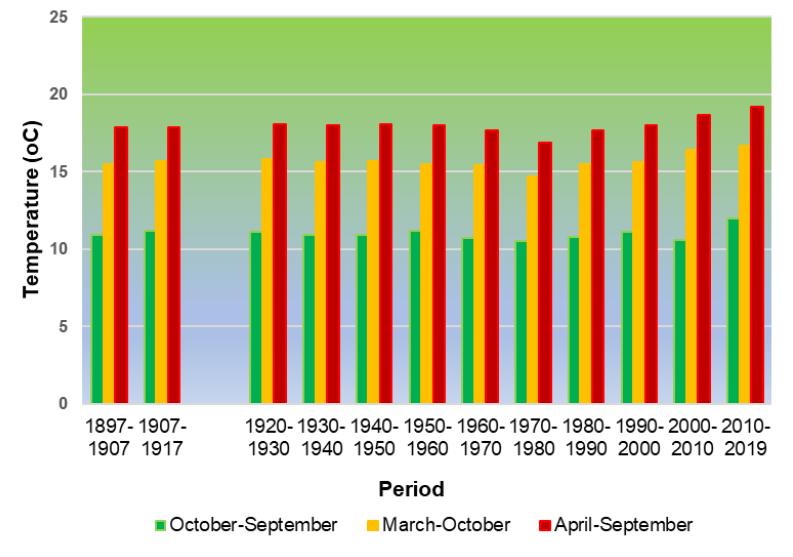
Figure 5. The evolution of the temperature of 1897–2019 represented over periods of 10 years.